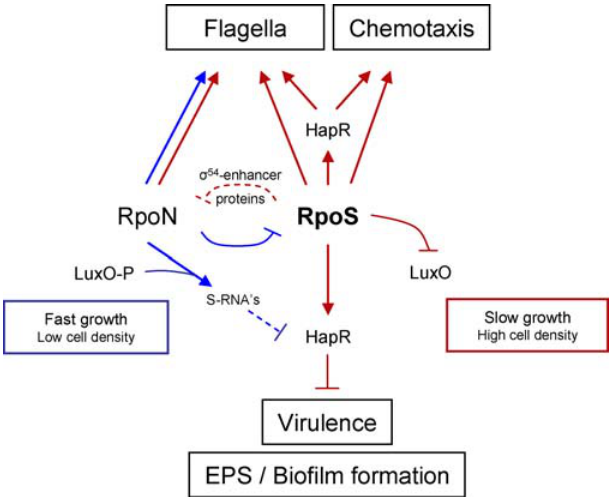
Figure 7. Model Depicting the Role of RpoS in the Regulation of CT (Virulence), Extracellular Polysaccharide, and Chemotaxis/Motility Genes during Different Growth States (Fast and Slow) The regulation of functions during the initial stages of infection, characterized by fast growth and low-cell density, is shown in blue. Regulation late in the infection, characterized by slow growth and high- cell density, is shown in red. Solid arrows indicate direct transcriptional regulation whereas dotted arrows indicate indirect transcriptional or posttranslational regulation. During low-cell density and fast growth, RpoS is largely silent. However, RpoN acts as an inducer of flagellar biosynthesis. LuxO is phosphorylated and acts as an RpoN enhancer protein causing the production of small RNAs that degrade the virulence repressor HapR [51]. This in turn leads to induction of virulence functions and EPS production. By contrast, during conditions of slow growth and high-cell density, RpoS together with RpoN is required for the